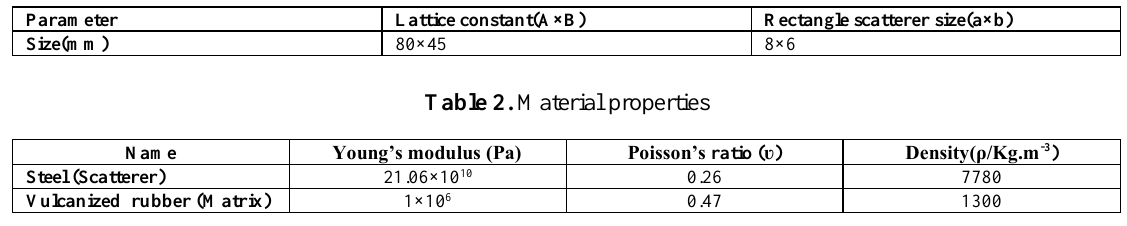
Table 1. Model parameters as used in the model represented in Figure 4